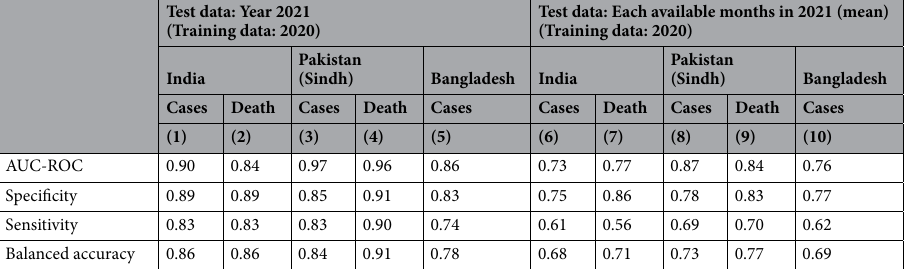
Table 3. Predictive Performance of the CR Index using 2021 as test data and 2020 as training data (District wise). The table provides the predictive accuracy results using multiclass classification. Districts belong to the red zone if covid-19 cases are greater than or equal to the 90th percentile; orange zone if cases fall within the 90th and 25th percentile; and green zone if below the 25th percentile. Column (1)–(5) use the entire 2020 as the training data and 2021 as the testing data using the early-late split method of cross validation. Column (6)–(10) report the means computed using the 12-months average across all the available months in 2021 used separately as testing data and 2020 as the training